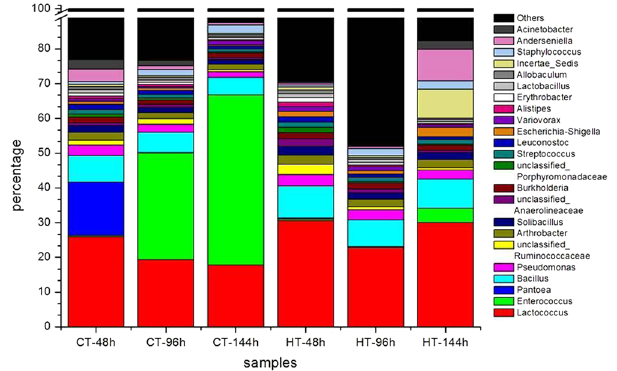
7 Scientific RepoRts | 7: 3349 | DOI:10.1038/s41598-017-03565-4